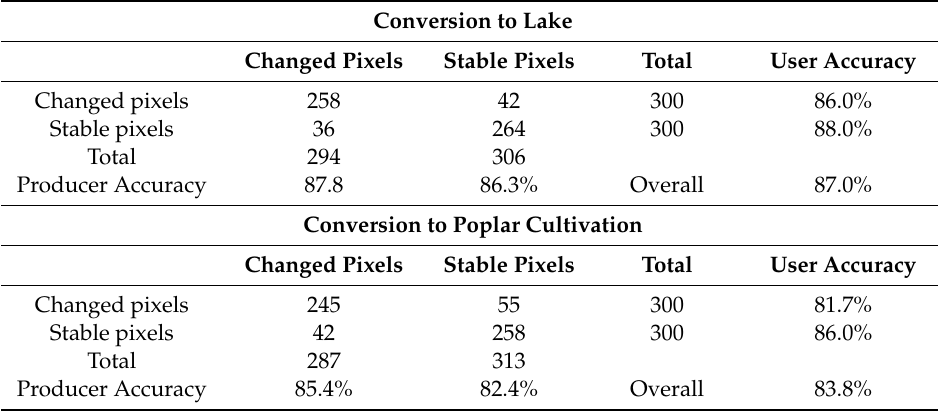
Figure 9. Landsat spectral trajectories and LandTrendr fitted trajectories in typical areas (crosses indicate trajectory locations) for (a,c) conversion to lake and (b,d) conversion to poplar cultivation. Related imagery (a1,b1,bands 4–5–3) and corresponding Landsat classification results(a2,b2) are also shown at left. Table 4. Accuracy assessments for change detection in both conversion patterns.